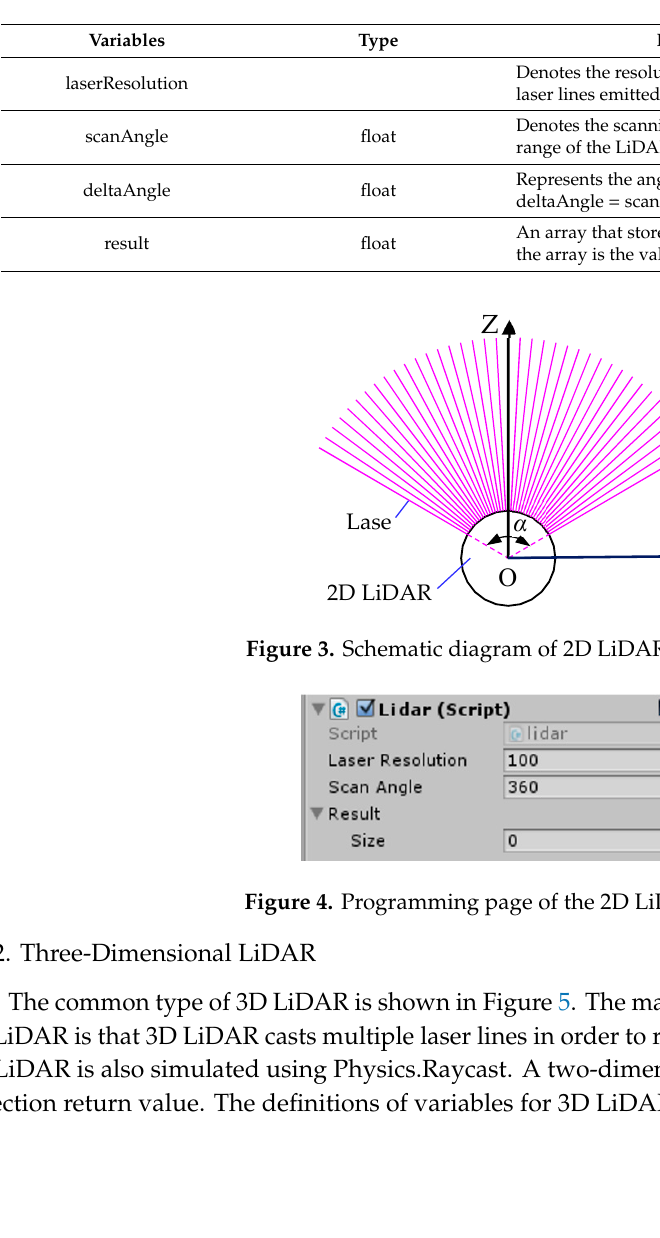
Figure 5. Three-dimensional LiDAR photos: ( a ) Velodyne VLP-16 LiDAR; ( b ) Velodyne HDL-64E LiDAR; ( c ) RoboSensep’s RS-LiDAR-32. Table 3. Definition of variables for 3D LiDAR simulation. Variables